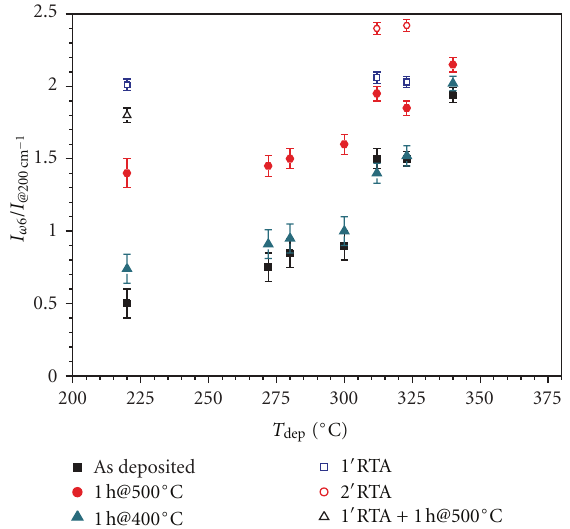
Figure 3: Deposition substrate temperature dependence of the relative intensity of the ω 6 phonon mode with respect to the background at 200 cm − 1 of the Raman spectra In 2 S 3 films as deposited (full squares) and after postdeposition annealing treat- ments. One hour annealing at 400 ◦ C in furnace (full triangles); one hour annealing at 500 ◦ C in furnace (full circles); one minute rapid thermal annealing at 500 ◦ C (open squares); two minutes rapid thermal annealing at 500 ◦ C (open squares); one minute rapid thermal annealing at 500 ◦ C followed by one hour annealing at 500 ◦ C in furnace (open